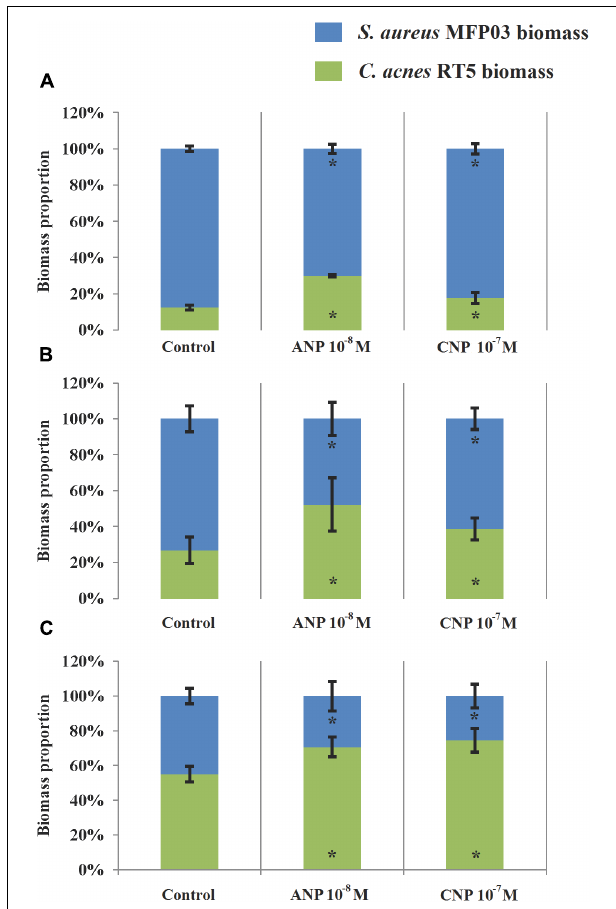
FIGURE 8 | Contribution of C. acnes RT5 and S. aureus MFP03 to binary biofilms formed in the absence or presence of ANP or CNP. (A) Simultaneously grown biofilms; (B) Biofilms based on pre-formed S. aureus MFP03 biofilms; (C) Biofilms, based on pre-formed C. acnes RT5. ∗ P <